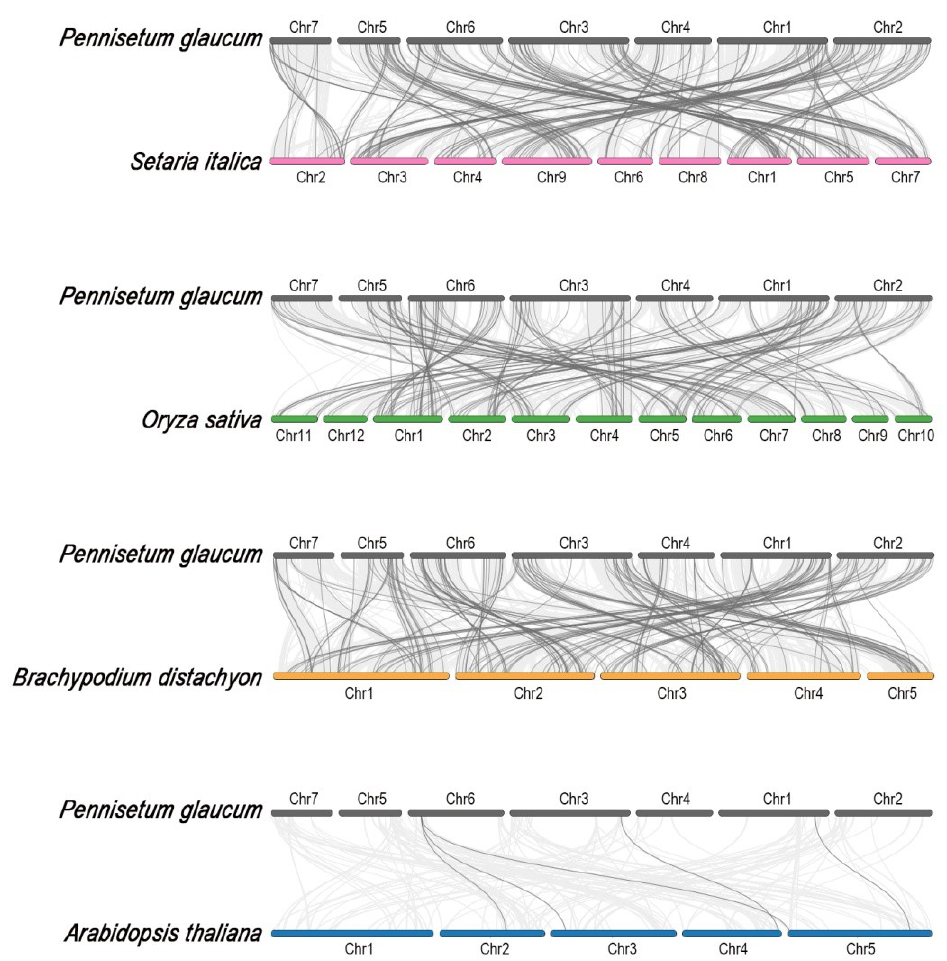
Figure 3. Synteny analysis of MYB genes between pearl millet and other model species. The light gray lines in the background indicate the collinear region within pearl millet and foxtail millet (pink), rice (green), Brachypodium (orange), and Arabidopsis (blue) genomes, while dark gray lines indicate syntenic MYB gene pairs, respectively.